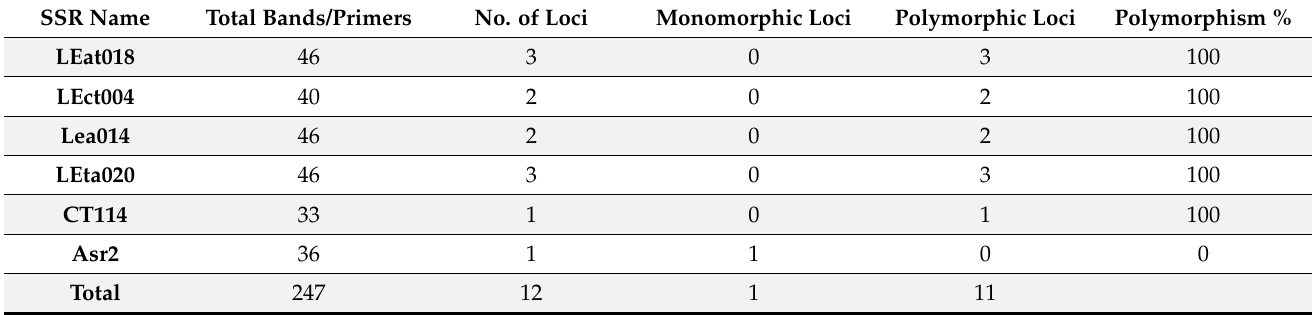
Table 4. Diversity parameters of tomato accessions obtained from the analysis of SSR